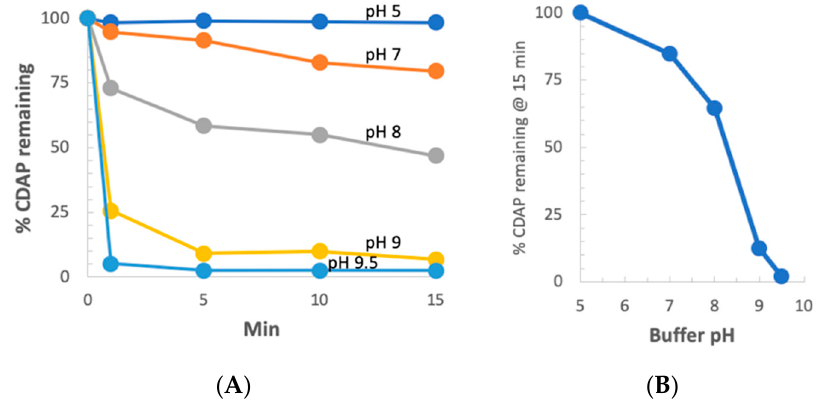
Figure 7. CDAP stability at 0 °C vs. pH. ( A ) CDAP was added to ice-cold solutions of 0.1 M buffer at pH 5–9 to a concentration of 2.5 mg/mL. At various times, a 25 µL aliquot was withdrawn and added to 975 µL of 0.1 M HCl and the absorbance read at 320 nm. ( B ) plot showing the data from Panel A at 15 min as a function of pH. The following 0.1 M buffers were used: HCl (pH 1), sodium acetate (pH 5), MES (pH 6), HEPES (pH 7 and 8) and sodium borate (pH 9 and 9.5).